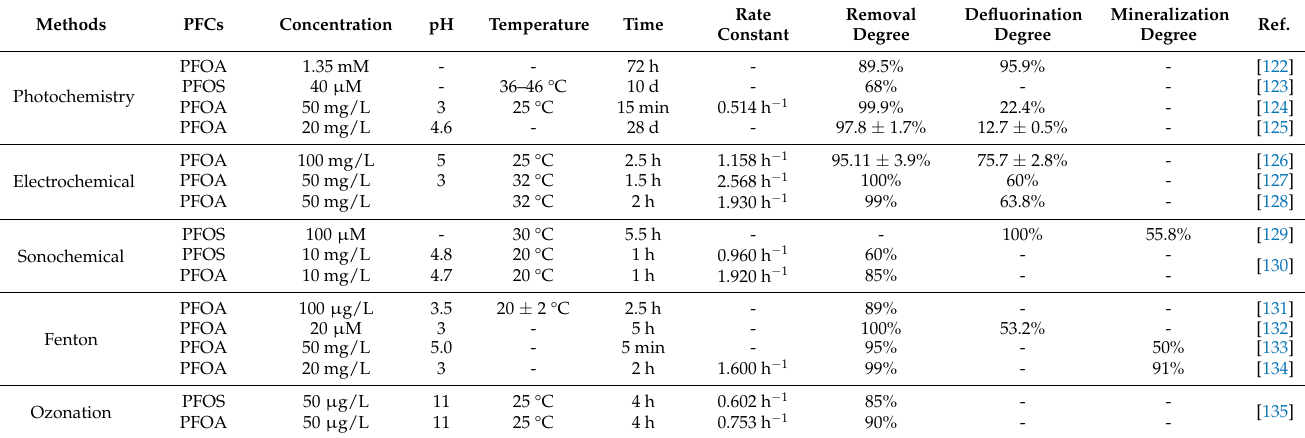
Table 3. Treatment effects of several chemical methods for degrading